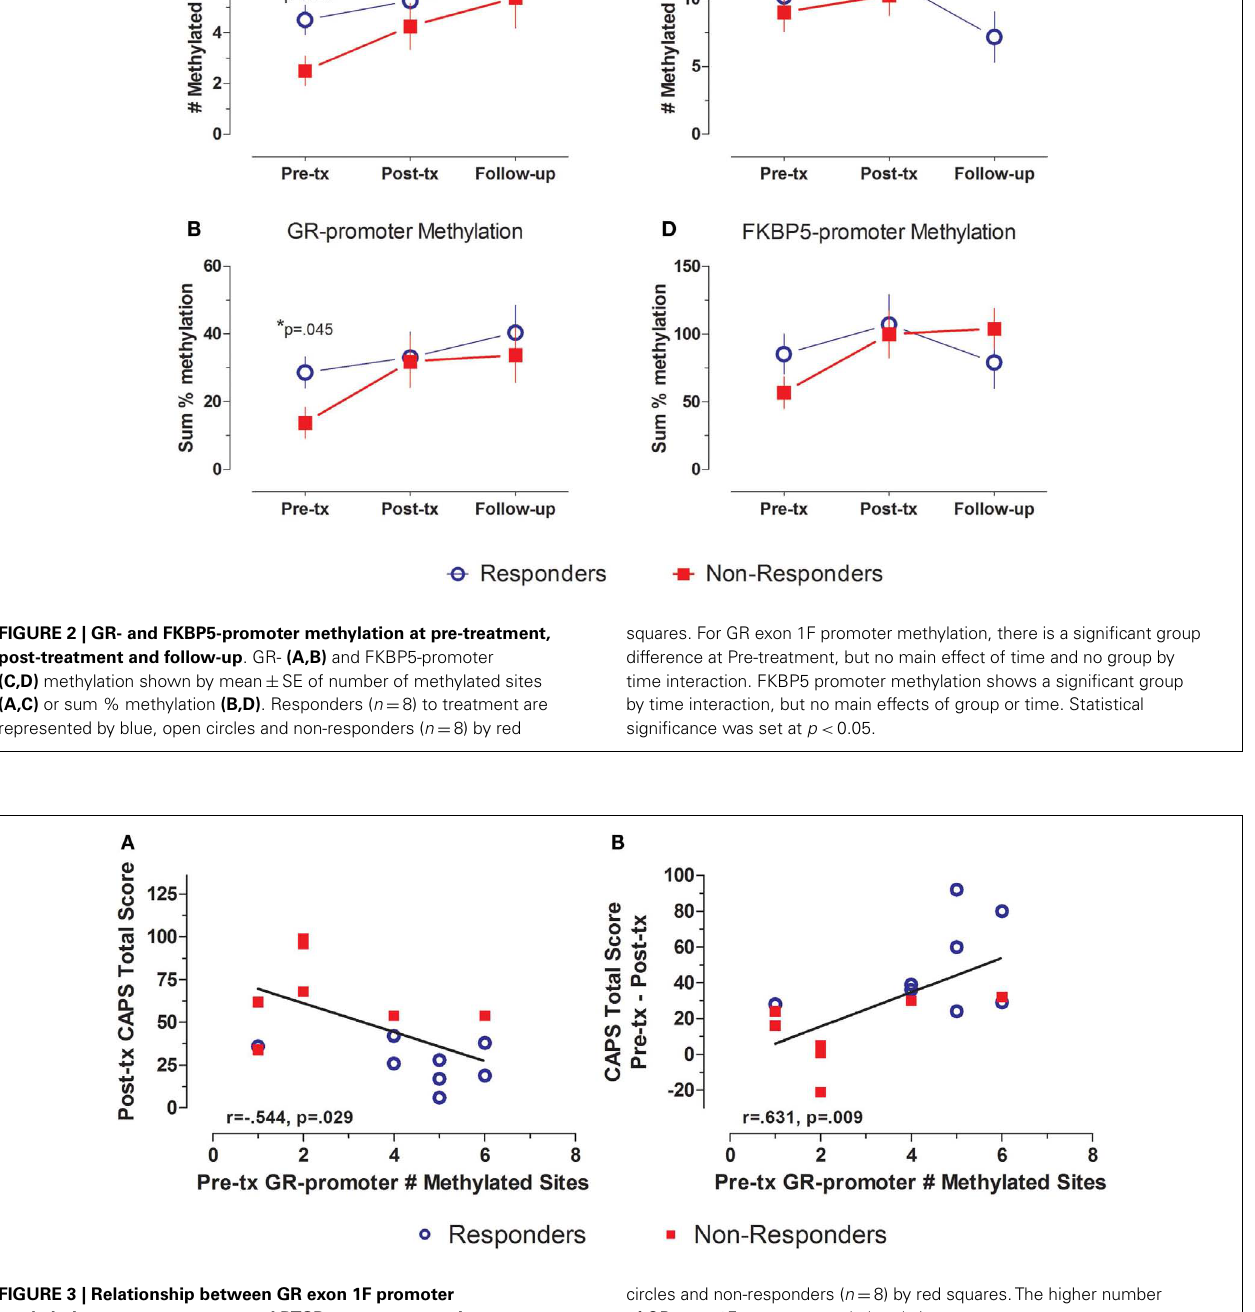
FIGURE 3 | Relationship between GR exon 1F promoter methylation at pre-treatment and PTSD symptom severity at post-treatment . Correlations of pre-treatment GR exon 1F promoter methylation (# of methylated sites) with post-treatment CAPS total score (A) and change in CAPS total score from pre- to post-treatment (B) . Responders ( n = 8) to treatment are represented by blue, open